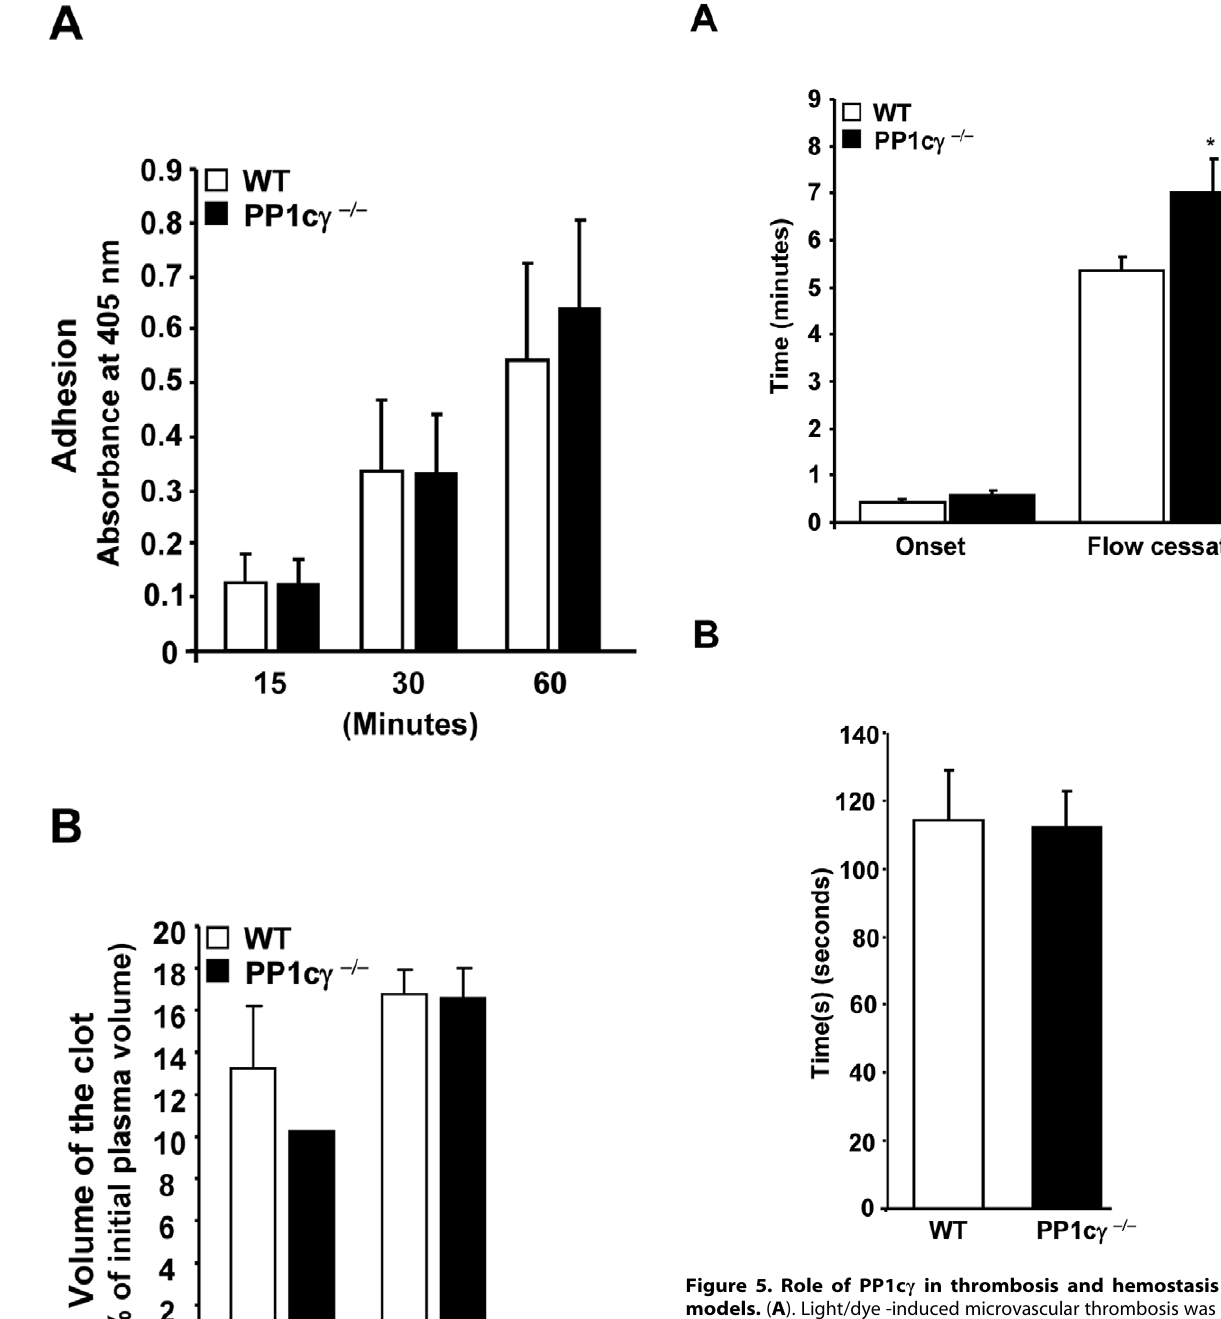
Figure 4. Outside-in integrin a IIb b 3 signaling functions in PP1c c 2 / 2 platelets. ( A ). Washed platelets were incubated with immobilized fibrinogen-coated micro titer wells for the indicated periods of time and adhesion quantified. The data are expressed as 6 SEM of 3 experiments. ( B ) Fibrin clot retraction was examined following the addition of thrombin to platelet-rich plasma. Volume of the clot is expressed as 6 SEM of 3 experiments.